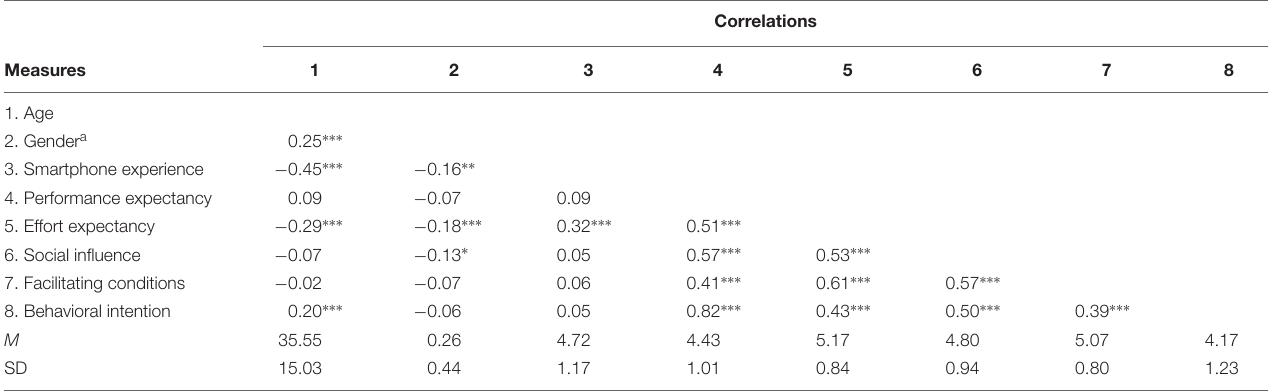
TABLE 1 | Means, standard deviations, and correlations for all